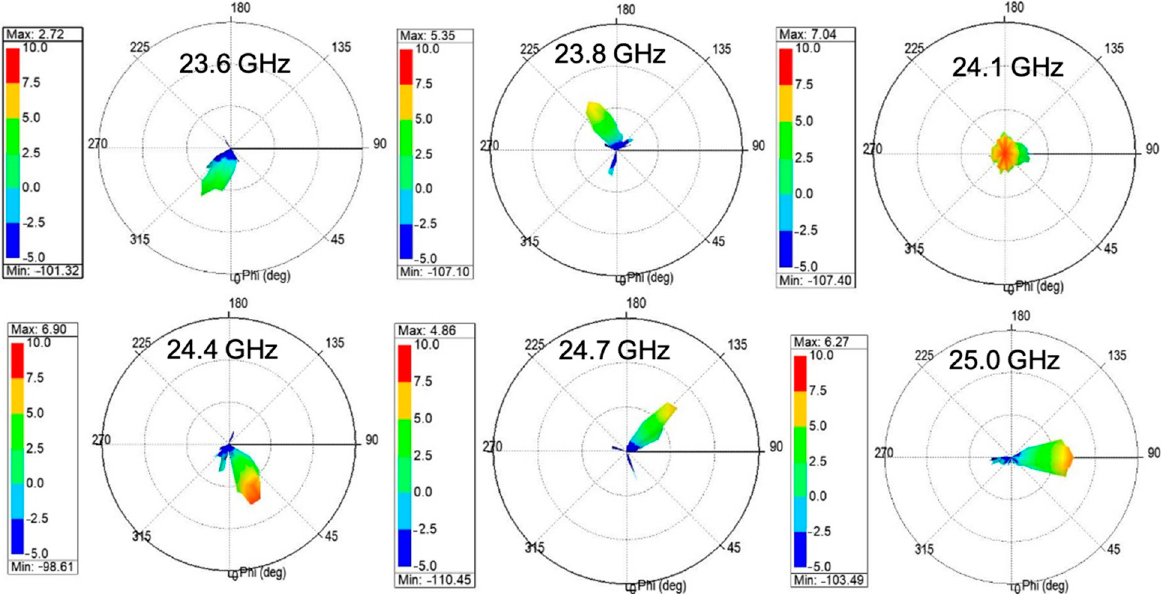
Figure 25. Radiation pattern of 2D MTM LWA array at 24 GHz band